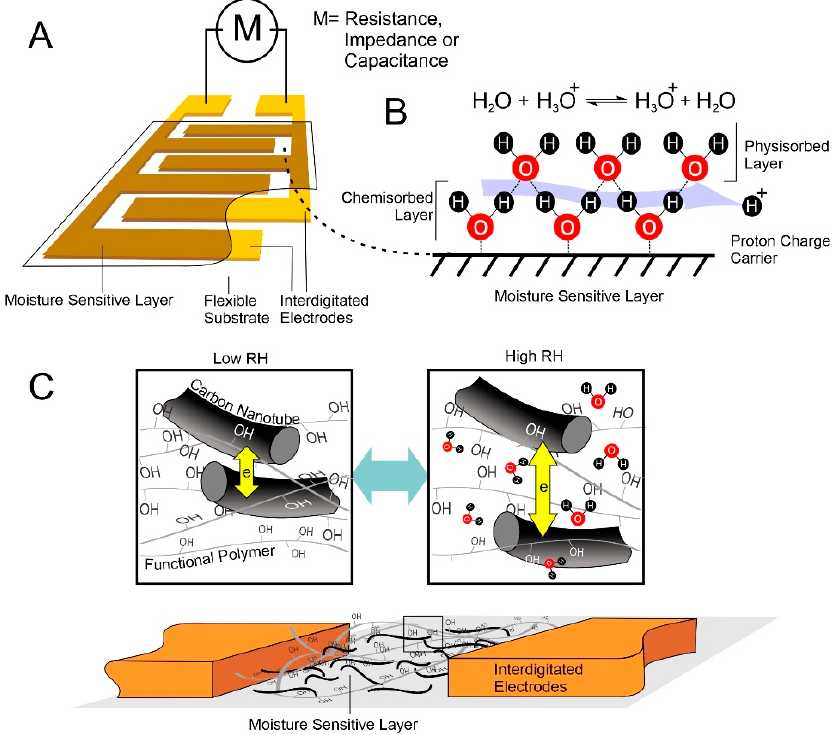
Figure 2. ( A ) Typical format of electrochemical humidity sensors and the resistive sensing methodologies associated with ( B ) ionic conduction and ( C ) physical changes brought about through swelling of the moisture sensitive film.